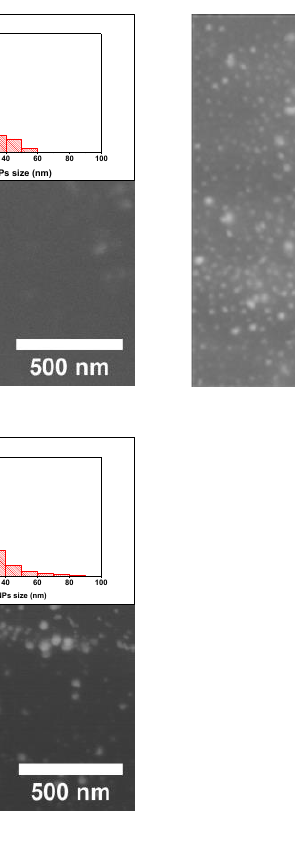
Figure 5. HRSEM micrographs and NPs size distribution (insets) of the ME/PDMS/Au foams obtained after different reaction times in 0.35 mg/mL of HAuCl 4 in ethanol: 1 ( a ), 24 ( b ), and 120 h ( c ).